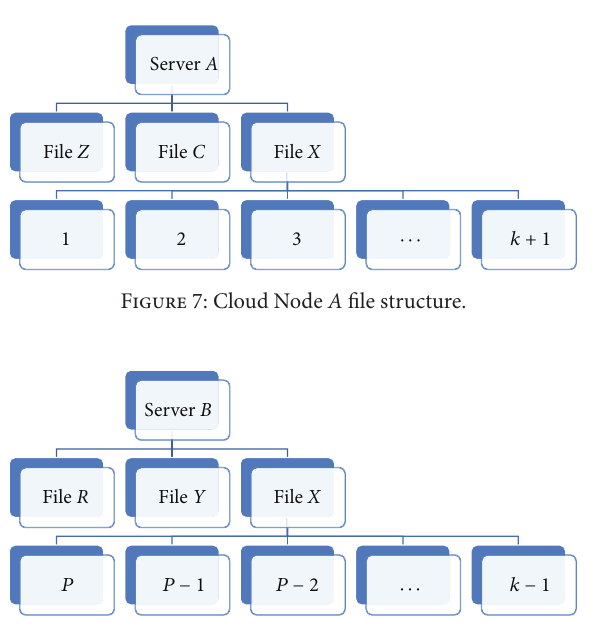
Figure 8: Cloud Node B file